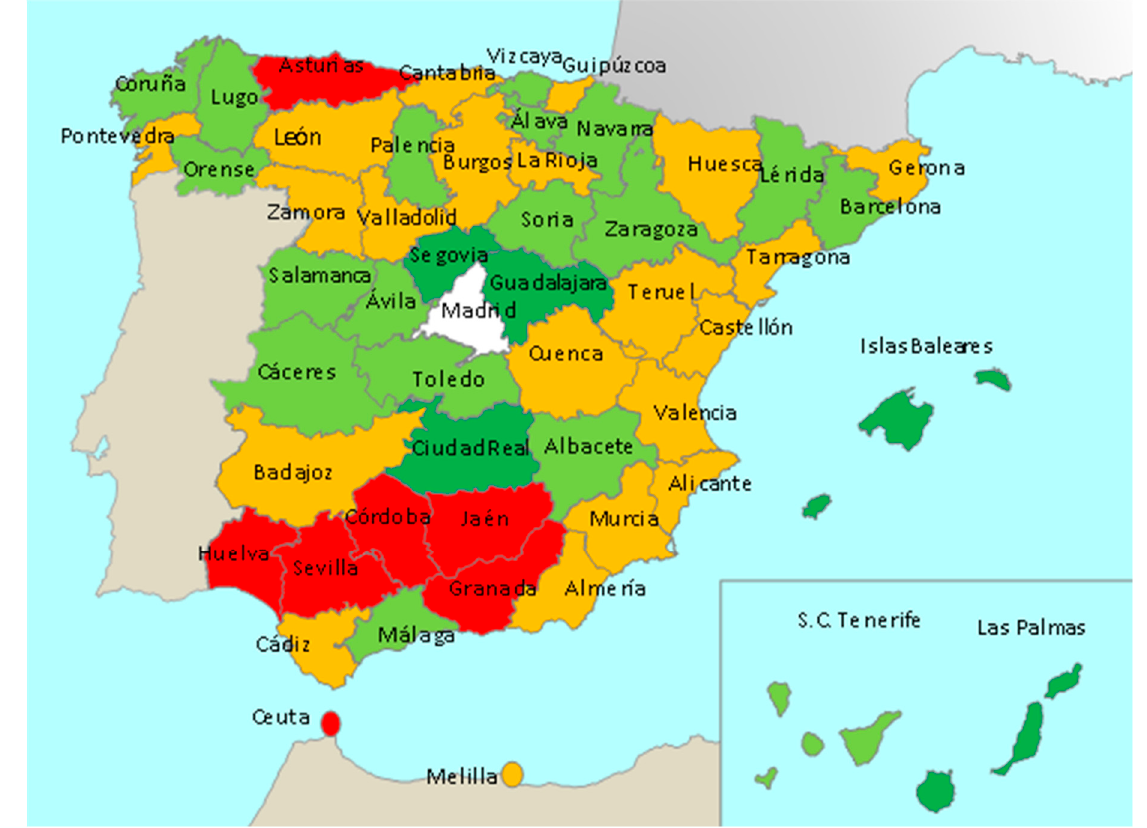
Figure 4. Geographical representation of estimated clubs in a map of Spanish provinces. The clubs are shown in different colors: Club 1 in red, club 2 in orange, club 3 in light green, club 4 in dark green, and the divergent behavior province (Madrid) in